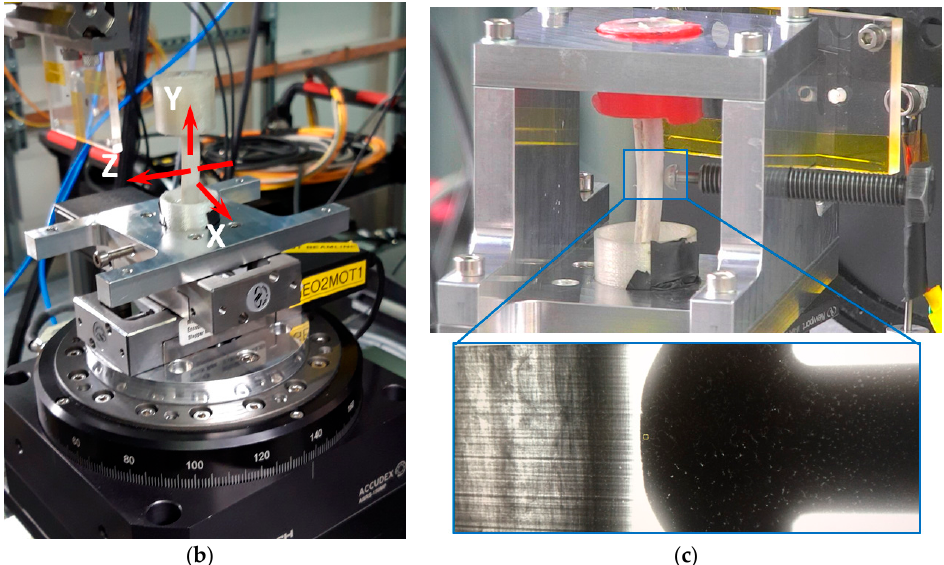
Figure 3. ( a ) Experimental synchrotron X-ray diffraction setup with developed load cell: ( b ) specimen position for tomography and ( c ) radiographic image of titanium bolt head used for application during in situ 3-point bending.